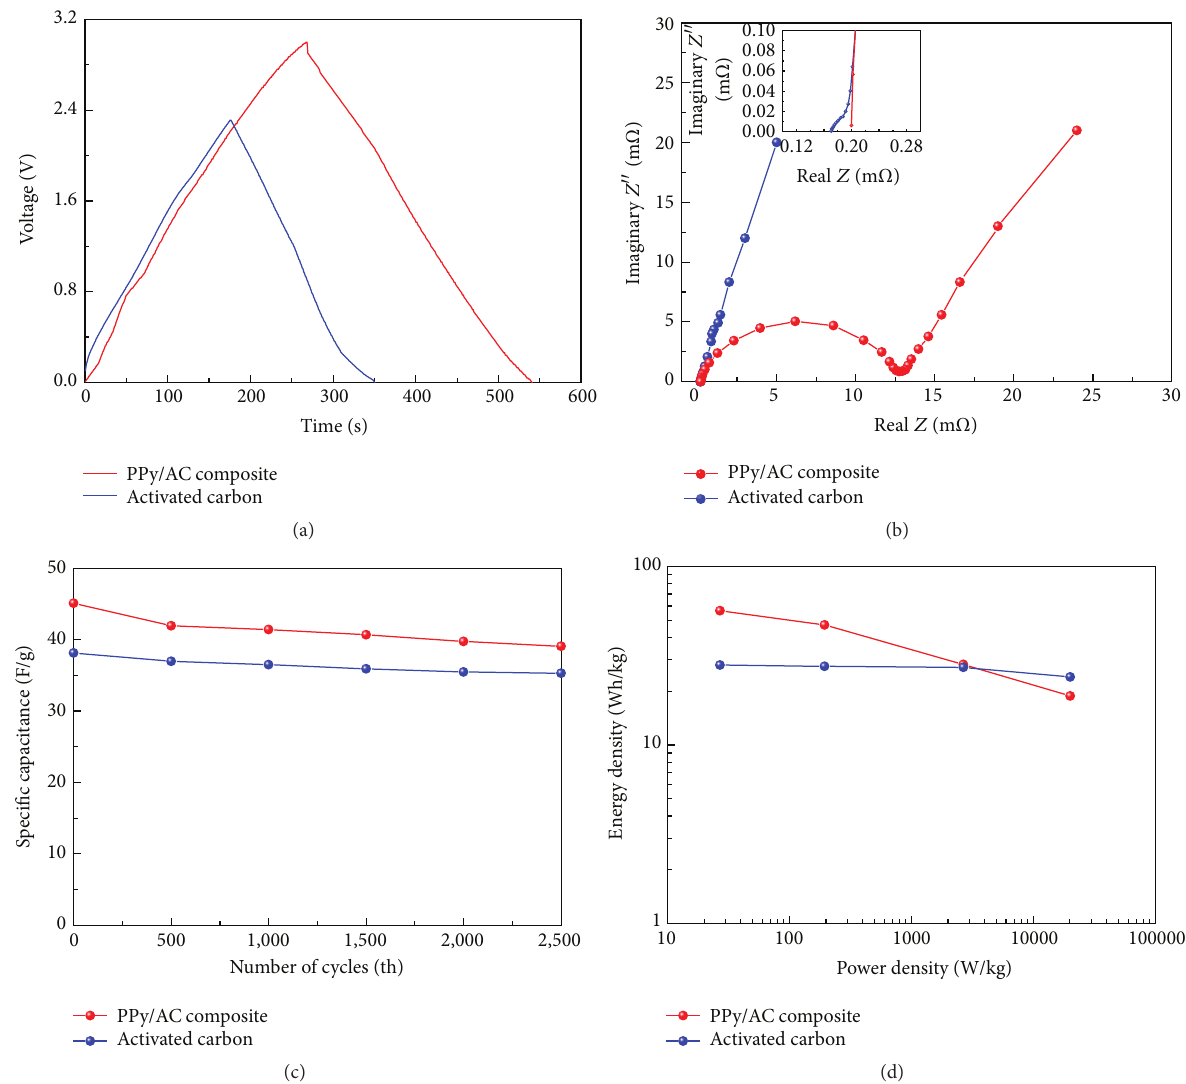
Figure 4: Comparison with electrochemical properties of supercapacitors using PPy/AC composite electrode and activated carbon electrode. (a) Galvanostatic charge-discharge curves. (b) The Nyquist plots. (c) Cyclic stability test. (d) Ragone plot.